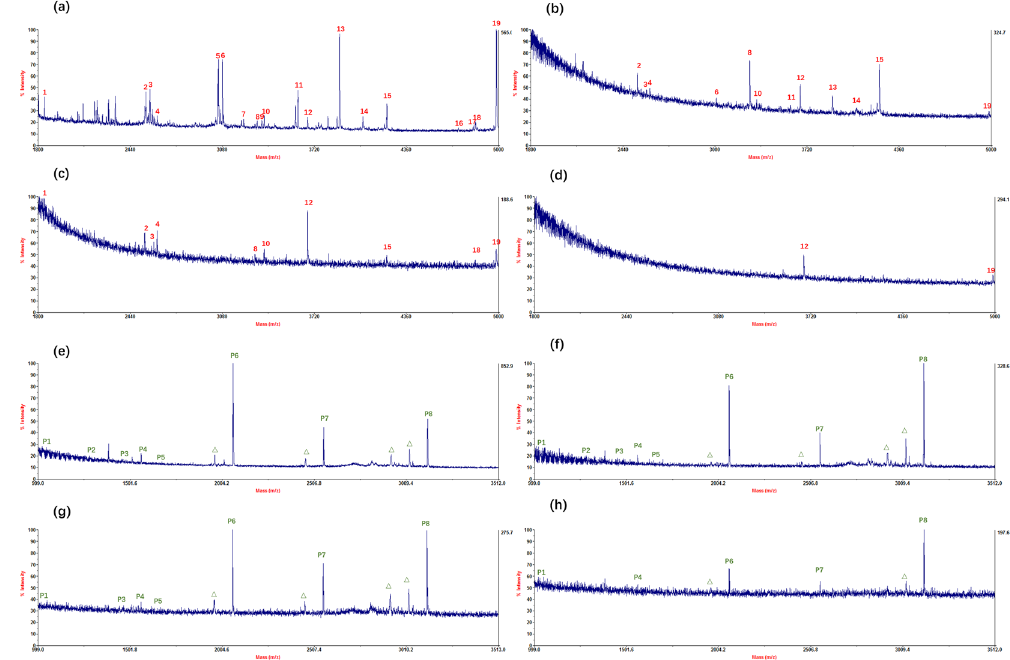
Figure 3. MALDI-TOF mass spectra for the glycopeptide enrichment from HRP tryptic digest: ( a ) 25 fmol/ μ L, ( b ) 5 fmol/ μ L, ( c ) 1 fmol/ μ L, and ( d ) 0.2 fmol/ μ L; for the phosphopeptide enrichment from β -Casein tryptic digest: ( e ) 25 fmol/ μ L, ( f ) 1 fmol/ μ L, ( g ) 0.2 fmol/ μ L, and ( h ) 0.02 fmol/ μ L, where glycopeptides were marked with Arabic Numerals in red, phosphopeptides were marked with Arabic Numerals in green, and Δ indicates the losses of phosphoric